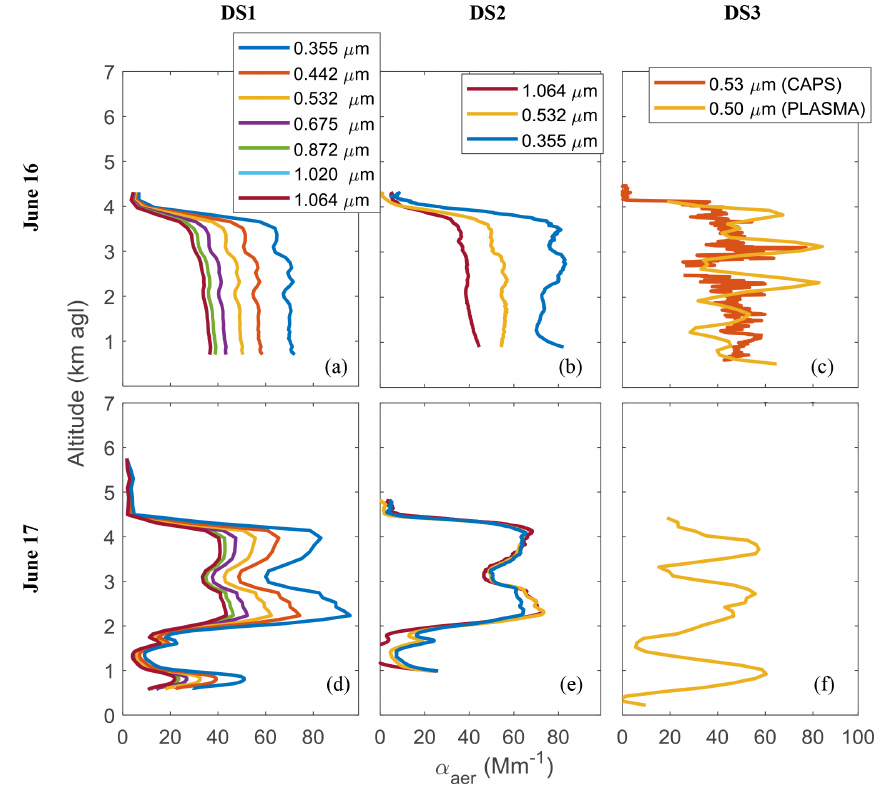
Figure 2. Profiles of α aer obtained from GRASP/DS1 (a, d) , Klett/DS2 (b, e) , and aircraft in situ/DS3 measurements (c, f) on 16 June (a, b, c) and 17 June (d, e, f)